Question: Produce a descriptive caption suitable for publication.
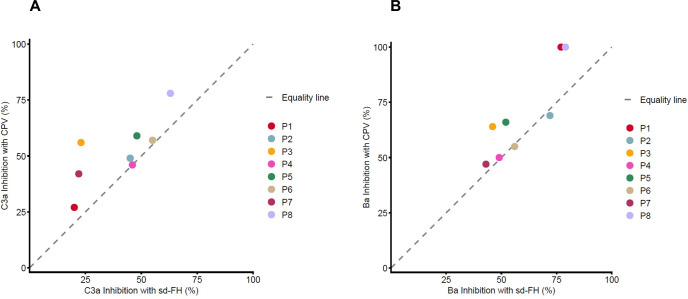
Answer: Comparison of CPV-104 and sd-FH inhibitory activity on complement activation. Equality plots showing the percentages of inhibition of C3a (A) and Ba (B) release achieved with CPV-104 (y-axis) versus those with sd-FH (x-axis) in sera from eight C3G patients. Each point represents an individual patient (P1–P8). Percent inhibition was calculated based on Δ(T1–T0) values. The dashed line indicates the line of identity (y = x). Data points above the line indicate greater inhibition by CPV-104 compared with sd-FH.